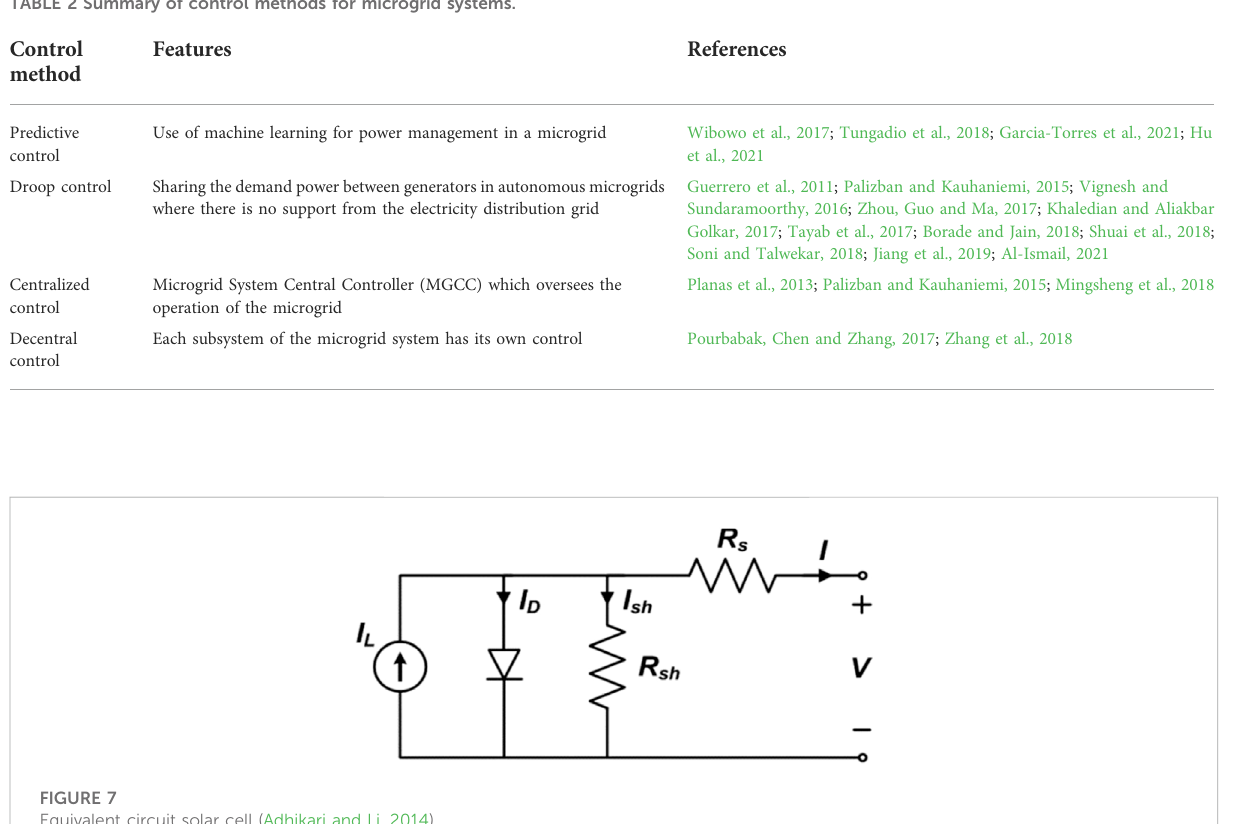
TABLE 2 Summary of control methods for microgrid systems.